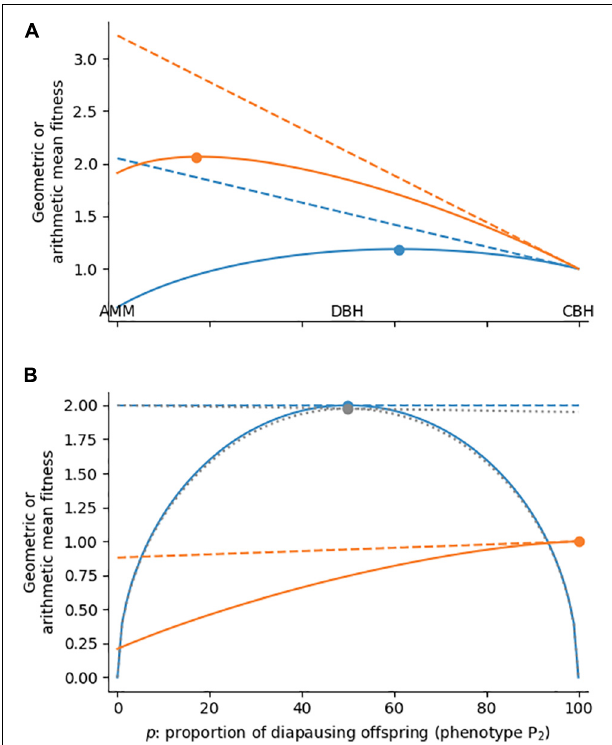
FIGURE 1 | Geometric (solid lines) and arithmetic mean fitness (dashed lines) when a genotype can express two discrete phenotypes in a two-state environment. (A) Conflict between geometric and arithmetic mean maximization. Environment E 2 (e.g., winter) occurs with frequencies of 0.5 (blue) or 0.2 (orange). Phenotype P 2 represents a risk-averse phenotype (e.g., diapausing offspring) with 1 fitness in either environment, the alternative phenotype is a phenotype with higher arithmetic mean fitness (4 fitness in E 1 , 0.1 in E 2 ). (B) No or little conflict between arithmetic and geometric mean maximization. Blue line: E 2 occurs with frequency 0.5 and P 1 and P 2 are specialists for E 1 and E 2 , respectively (4 fitness if matched, 0 fitness if mismatched); gray: same as blue line, but P 2 has 3.9 fitness in E 2 ; orange: fitness is the same as in panel (A) , but E 2 occurs with frequency 0.8. Colored dots represent the maxima of the respective